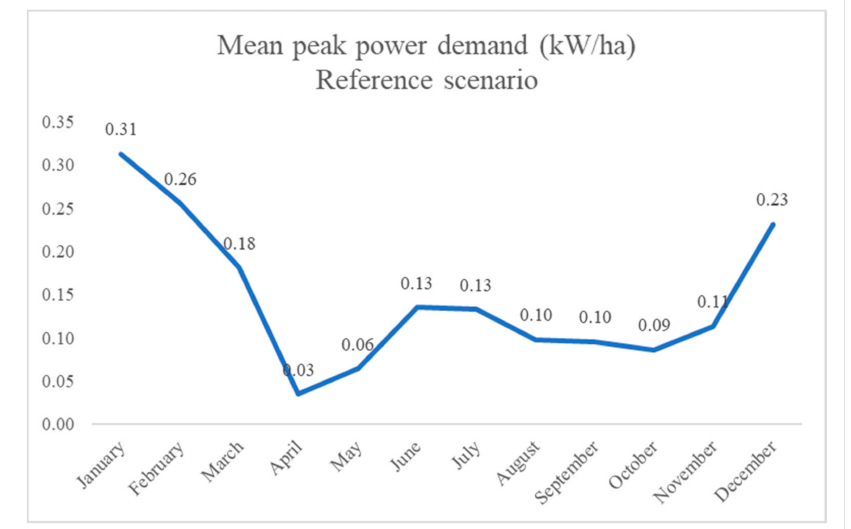
Figure 6. Peak power demand for irrigation water pumping in the reference scenario in January, April, July, and October. The results are presented as follows: ( a ) January, ( b ) April, ( c ) July, and ( d ) October. The results indicate a varying demand across the year in terms of scope and intensity.